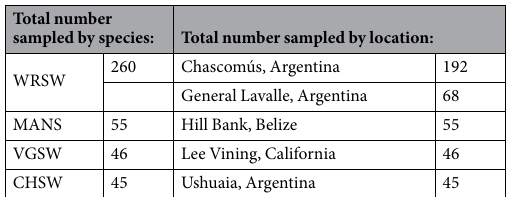
Table 2. Final sample sizes of nests/females used for the glm analysis with complete individual female information for the breeding synchrony (SI) model. Note that we did not use Tree swallows on this analysis, in spite of the fact that there are many papers on their genetic parentage, because we did not have access to individual female information from the papers used as reference. VGSW = Violet-green swallow, MANS = Mangrove swallow, WRSW = White-rumped swallow, CHSW = Chilean swallow.